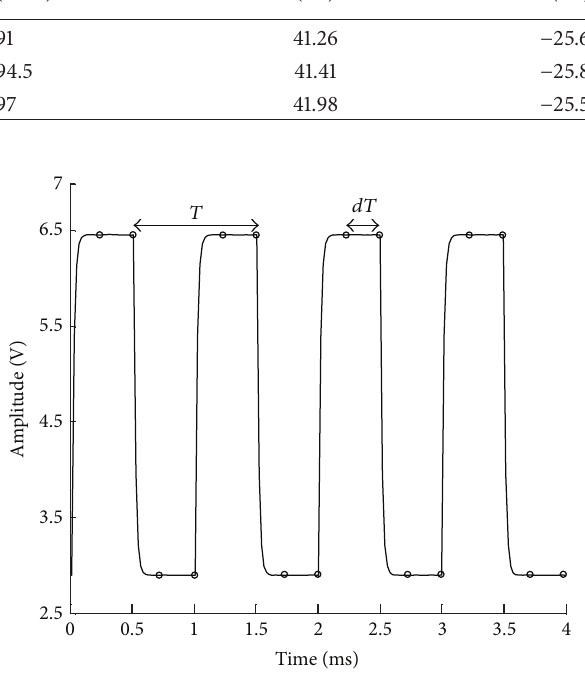
Figure 8: A typical output of the designed radiometer. Figure 9: Plot of the settling time coefficients under different values of 𝑁 and 𝜌 .